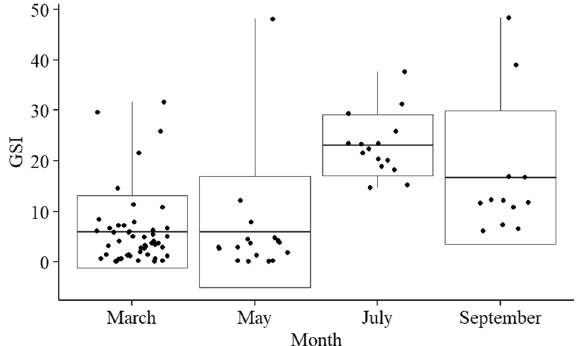
Figure 2. GSI for A. senhousia collected in March (n = 49), May (n = 18), July (n = 15) and September/October (n = 12) in 2019. The mean values are represented by the line in the centre of the box. Upper and lower limits